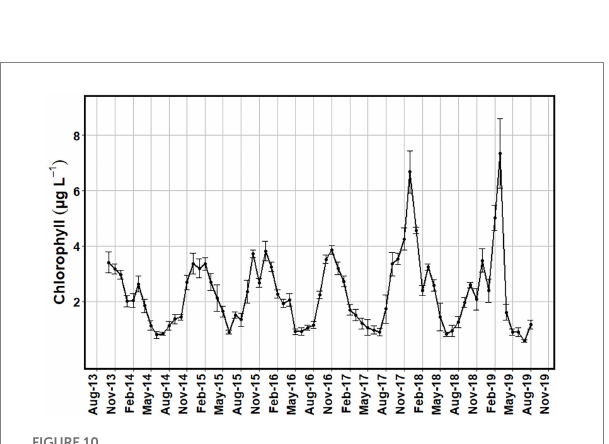
FIGURE 10 Monthly average surface chlorophyll ( μ g L − 1 ) values for the study region obtained from MODIS-Aqua satellite images with low cloud cover from October 2013 to August 2019. Error bars of one standard error were added to show the variance of the